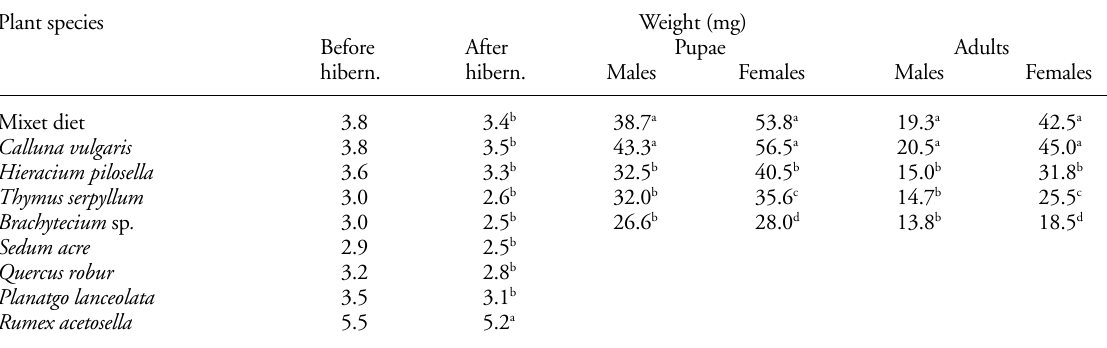
Table 2. Mean weight (mg) of D. ancilla larvae, pupae and adult moths on different plant species during development. Cohorts with less than five surviving larvae at any time during development have been excluded from the table. For pupae and adults, both male and female weights are given. Plant species Weight (mg) Before After Pupae Adults hibern.